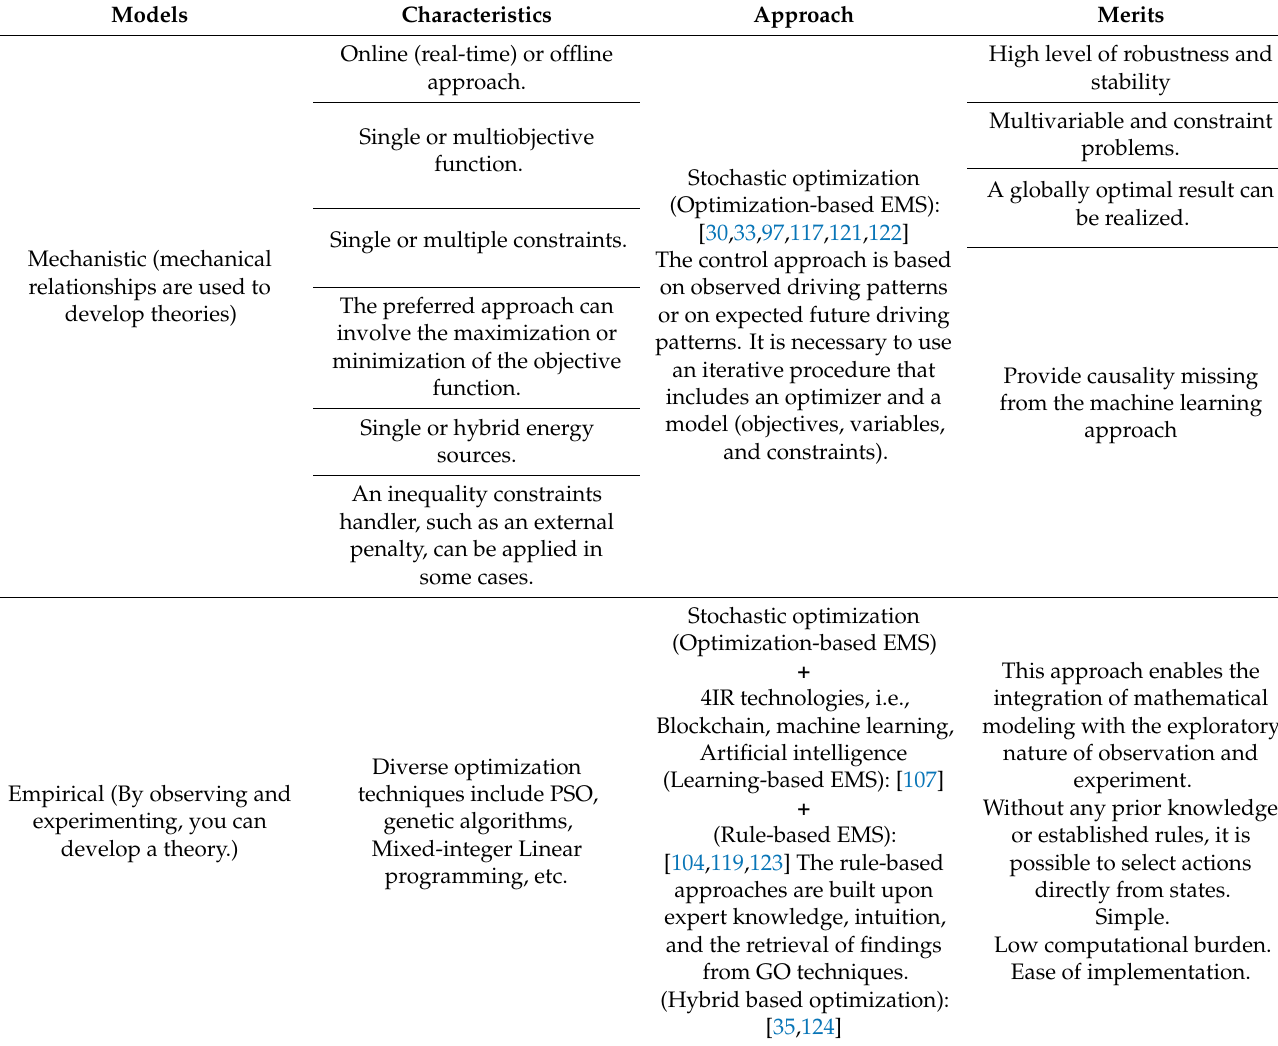
Table 6. A summary of models and various approaches used in the